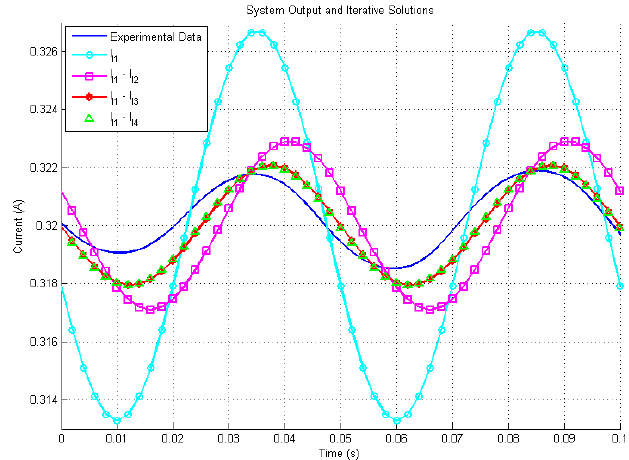
Figure 8. Experimental output and iterative